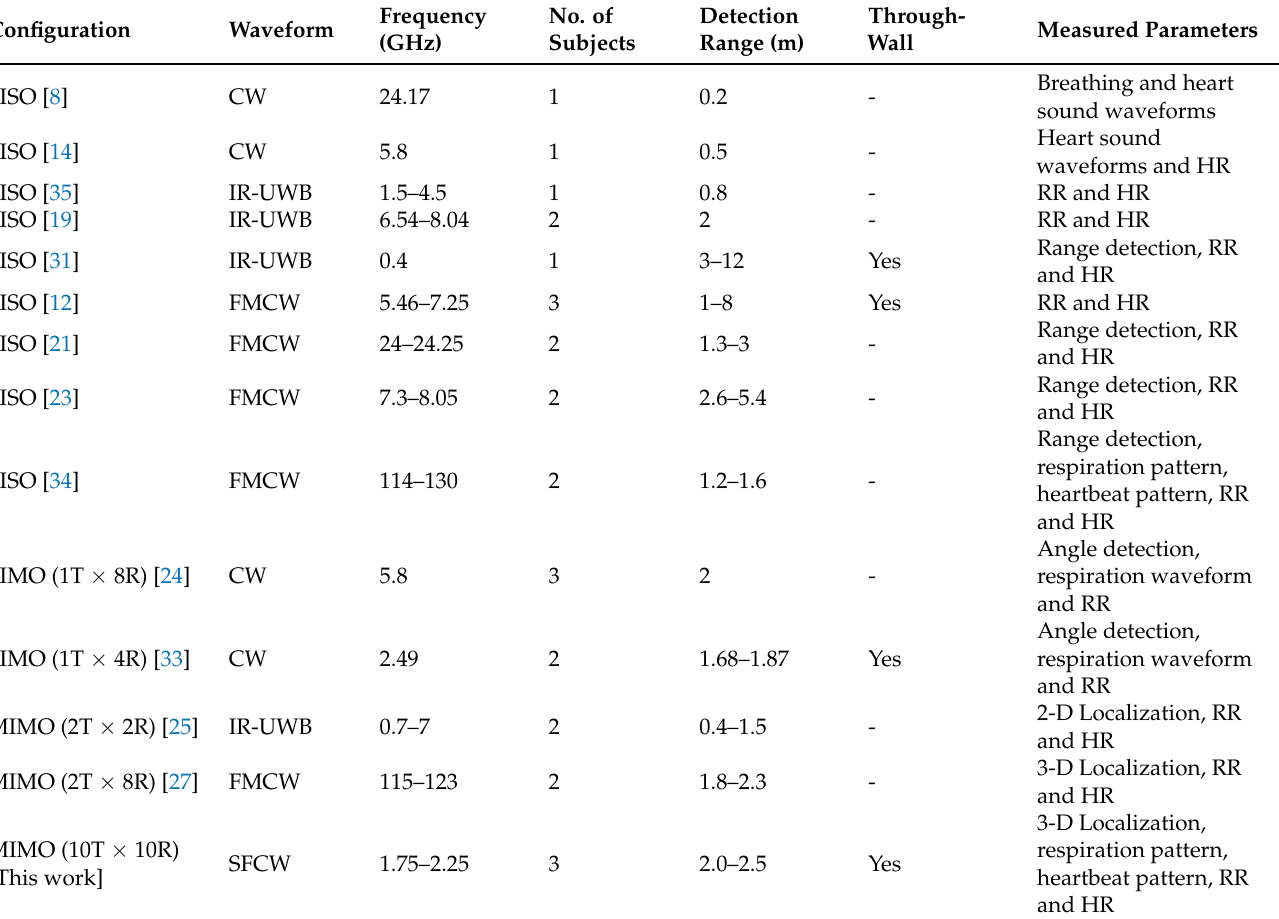
Table 1. A research review of vital signs monitoring with electromagnetic